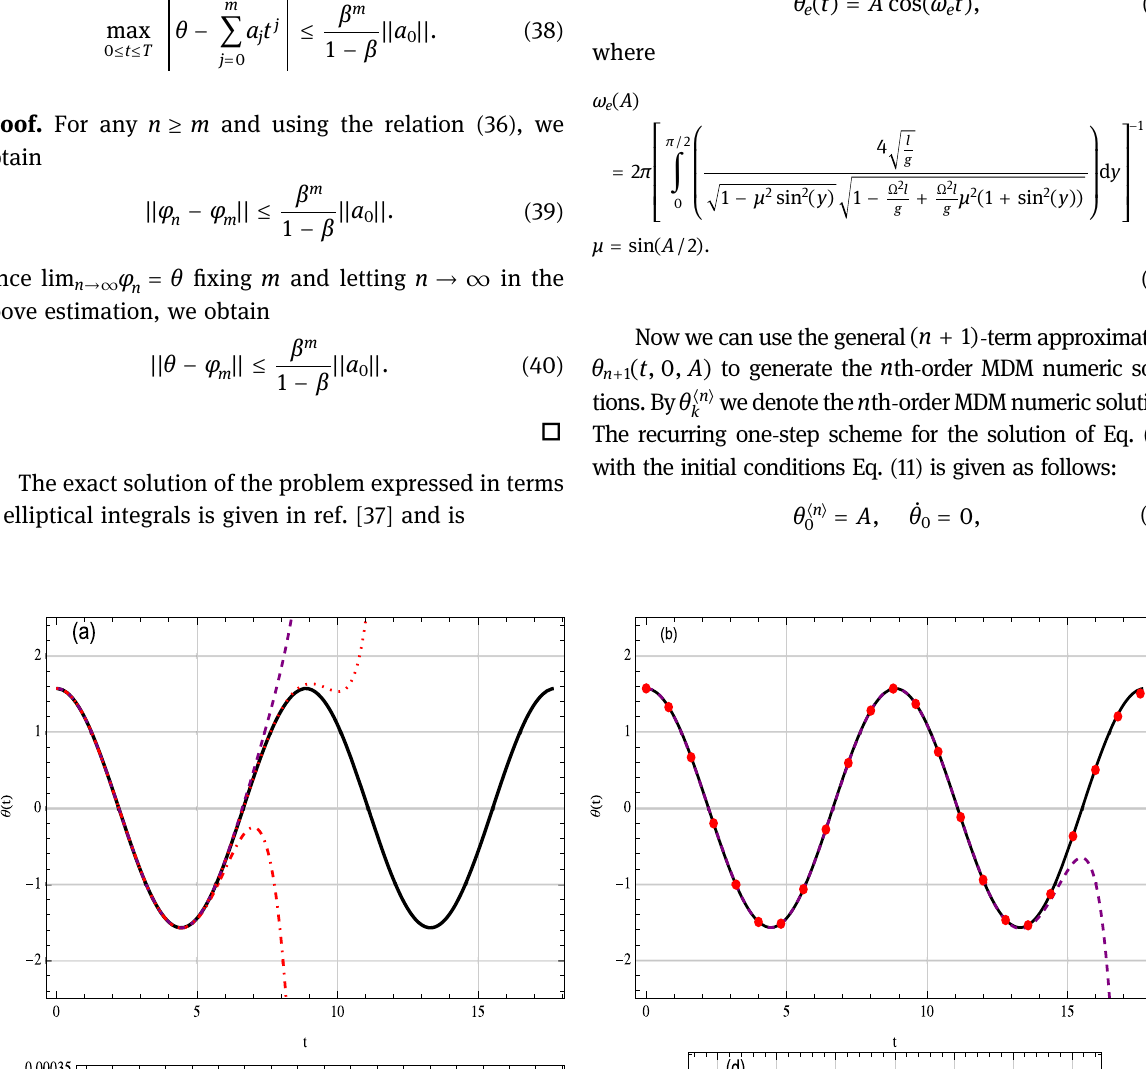
20 ⟨ ⟩ with step - size k 25 ⟨ ⟩ k